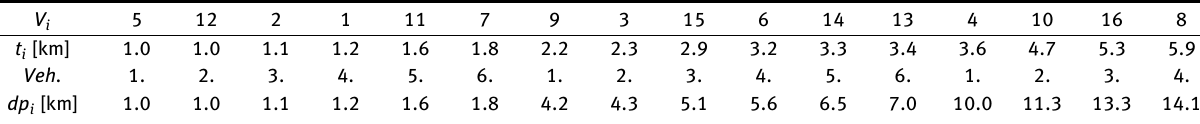
Table 9: The dpi parameter based on sorted distances between V 0 and Vi for six AGVs V i